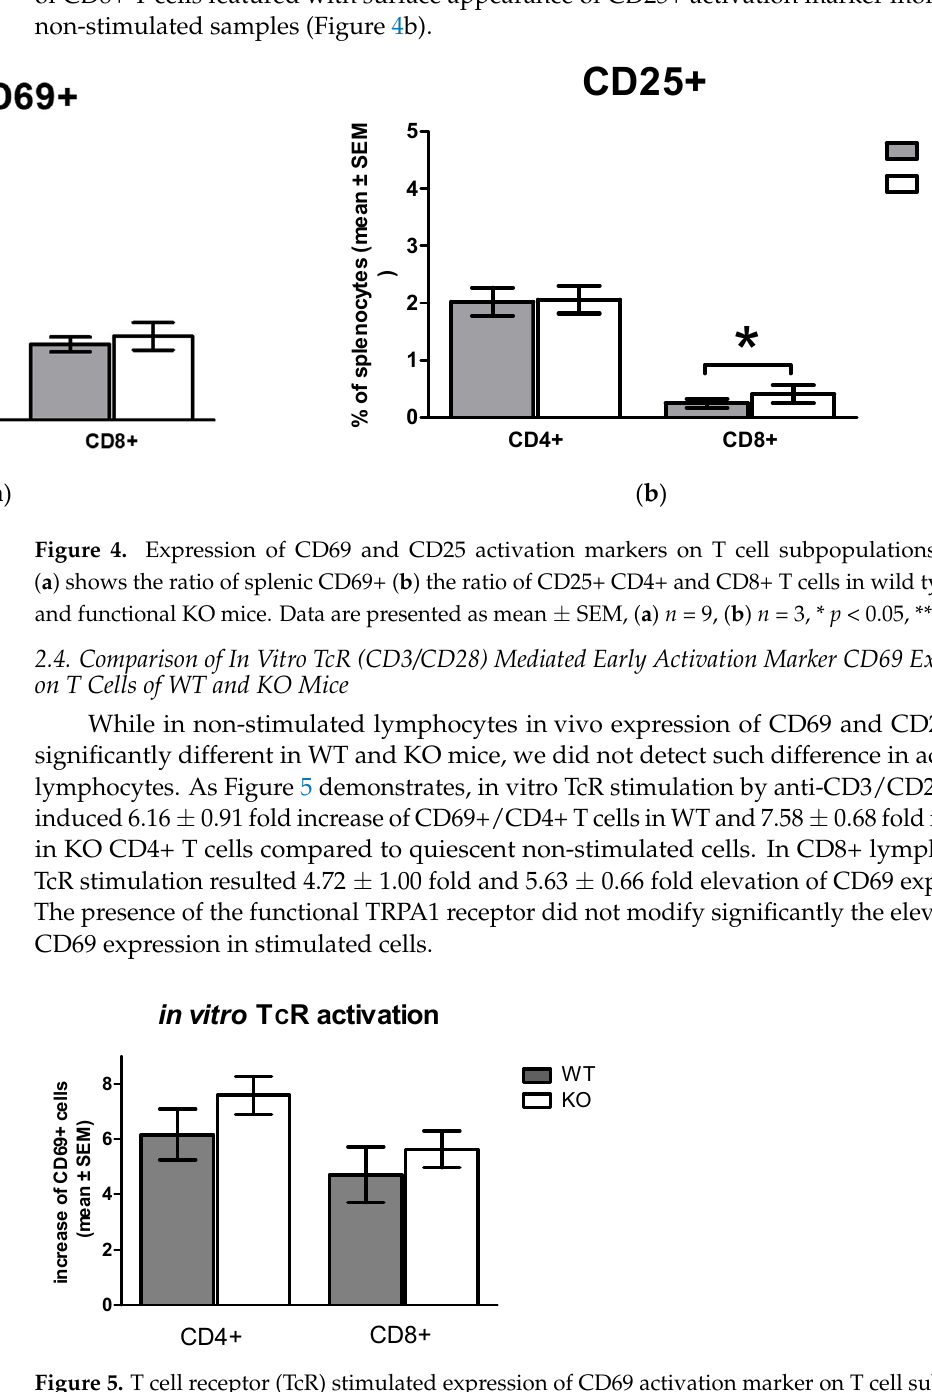
Figure 5. T cell receptor (TcR) stimulated expression of CD69 activation marker on T cell subpopula- tions in vitro. Elevation of CD69+ positive cells in CD4+ or CD8+ cell subpopulations is shown as the ratio of the percentage of CD69+ cells stimulated by anti-CD3/CD28 beads to that of unstimulated controls (CD69+ of stimulated/nonstimulated lymphocytes). Data are presented as mean ± SEM, n = 3, p > 0.05. No significant differences in activation marker CD69+ expression were detected between samples from WT and KO splenocytes.